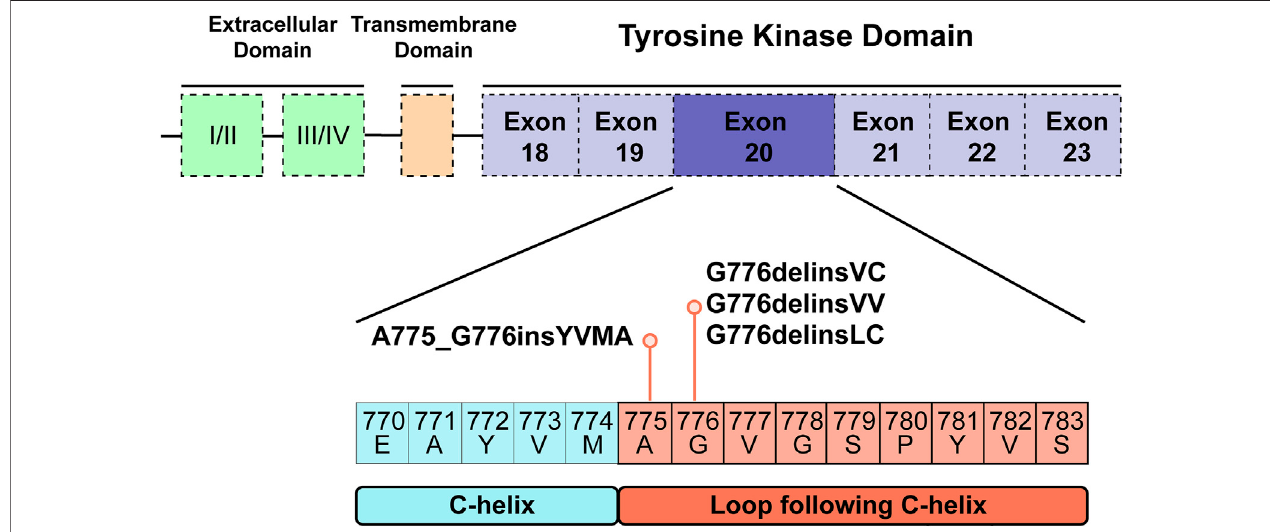
FIGURE 3 | 3D-based homology protein models ( HER2 wild type marked in yellow, HER2 mutants marked in pink) of HER2 exon 20 Gly776 deletion-insertion variant G776delinsVC with the small molecule TKI afatinib (A) , G776delinsVV (B) , G776delinsLC (C) , compared with the most common 12-bp in-frame insertion A775_G776insYVMA (D) .